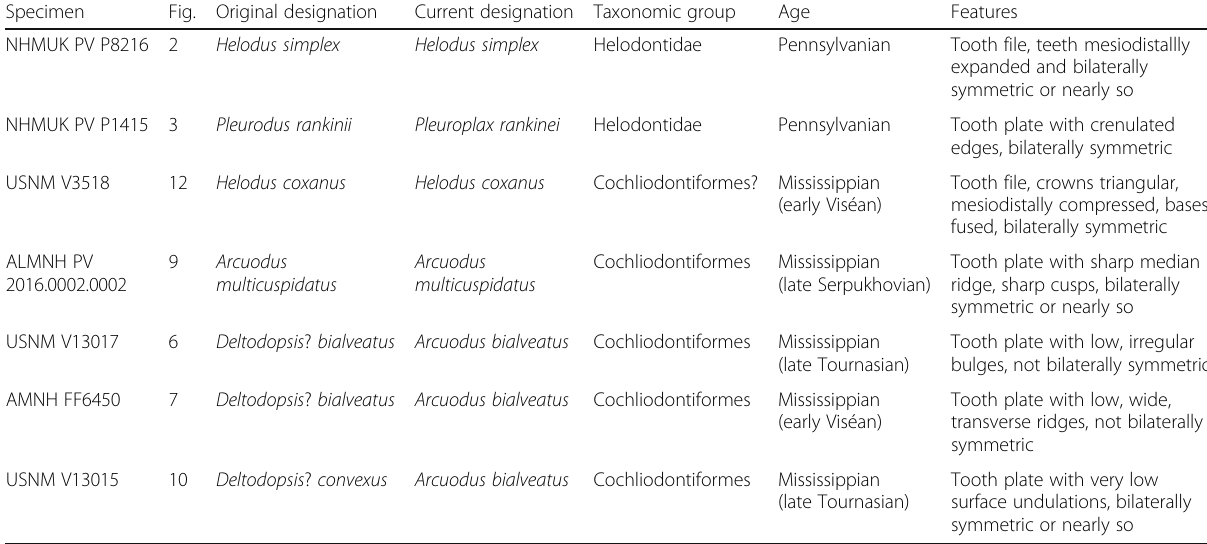
Table 1 Key specimens with taxonomy, ages, and